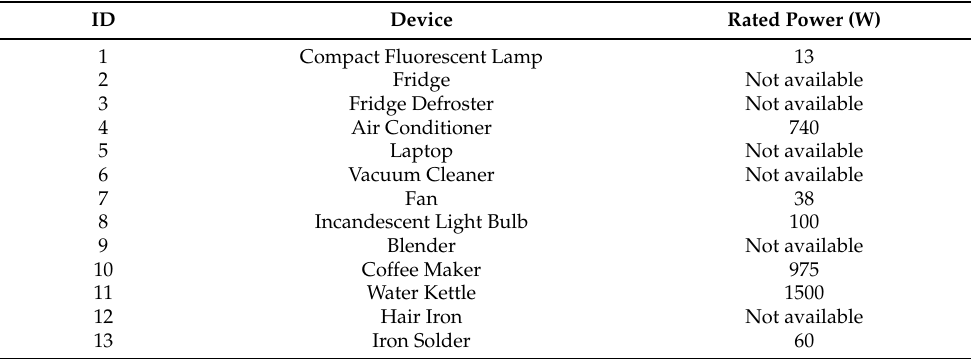
Table 2. Appliances in aggregated subset